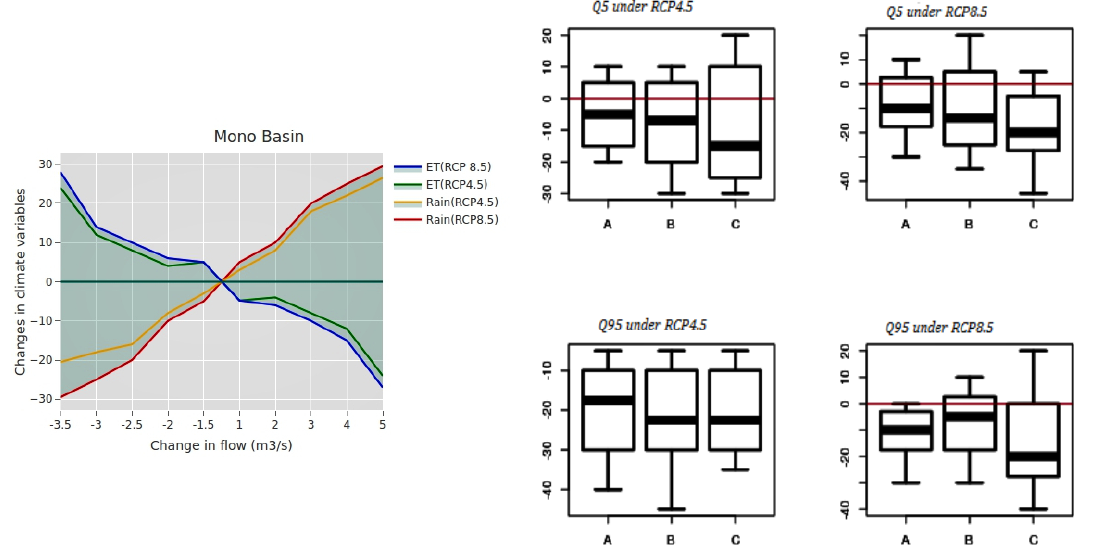
Figure 4. The relative mean changes of Q5 and Q95 under two RCPs (RCP4.5 and RCP8.5) in the future (A = 2051–2080, B = 2061–2090, C = 2071–2100). The changes from the reference period are assessed as shown by equation for Q5 and Q95 (to the right) and the sensitivity of flows to main Climatic Variables (to the